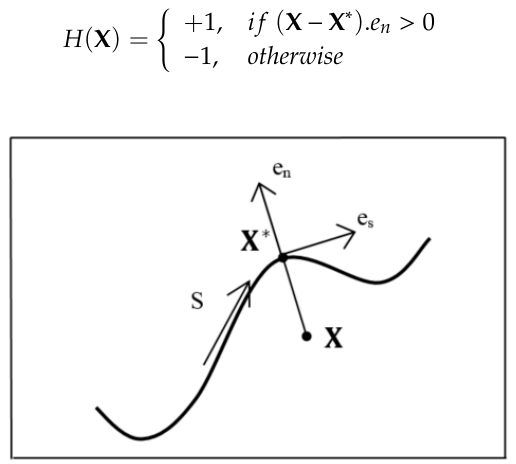
Figure 4. Unit tangential and normal vectors for the Heaviside function and nearest point to X on the crack surface; X ∗ .